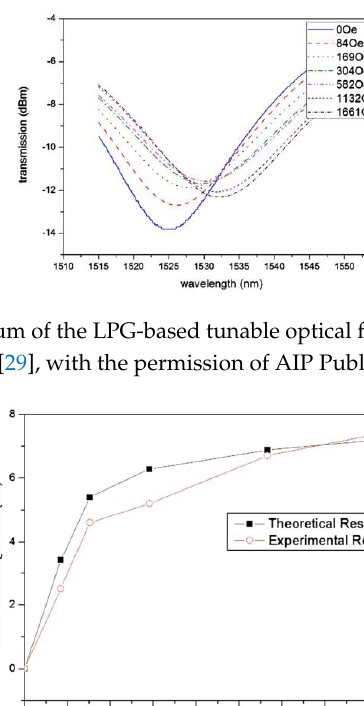
Figure 8. Schematic representation of a LPG.